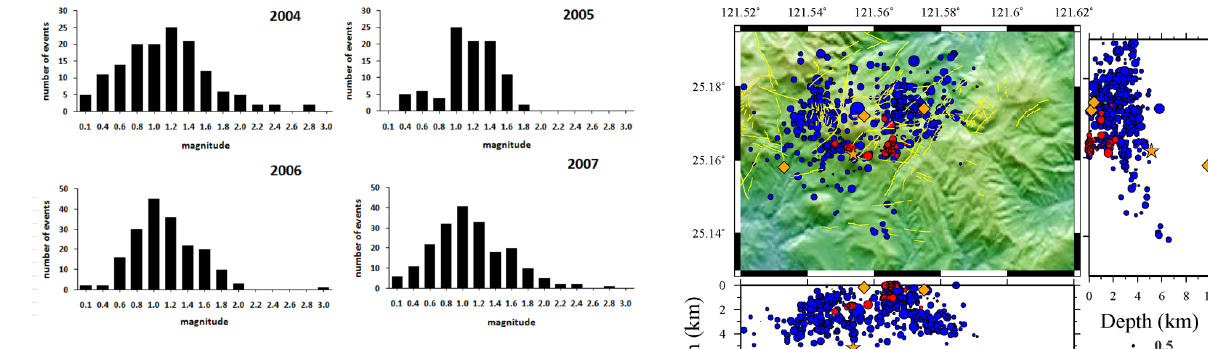
Fig. 6. Histograms showing the distribution of magnitude M L (for 2004) and M d (for 2005–2007) for all HF earthquakes estimated from our analysis (see text for more details).